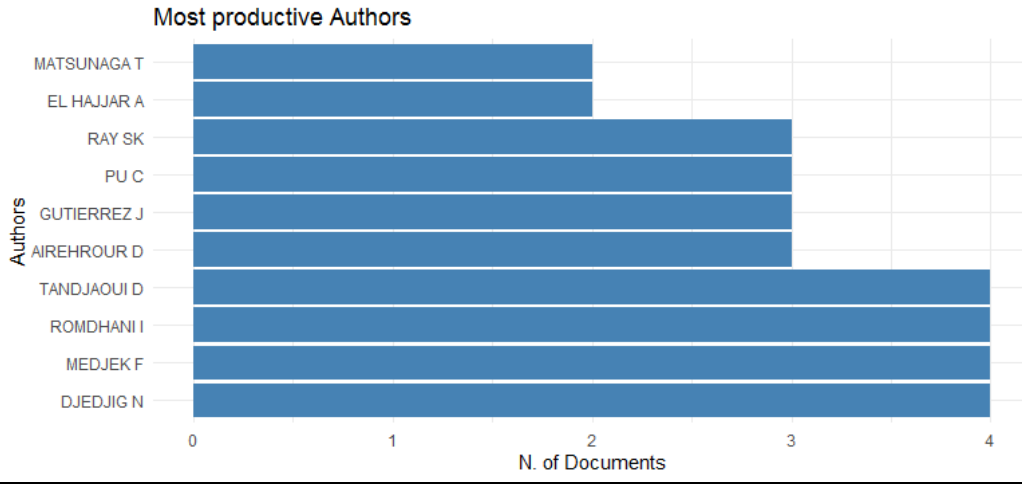
Figure 4. Most productive authors.